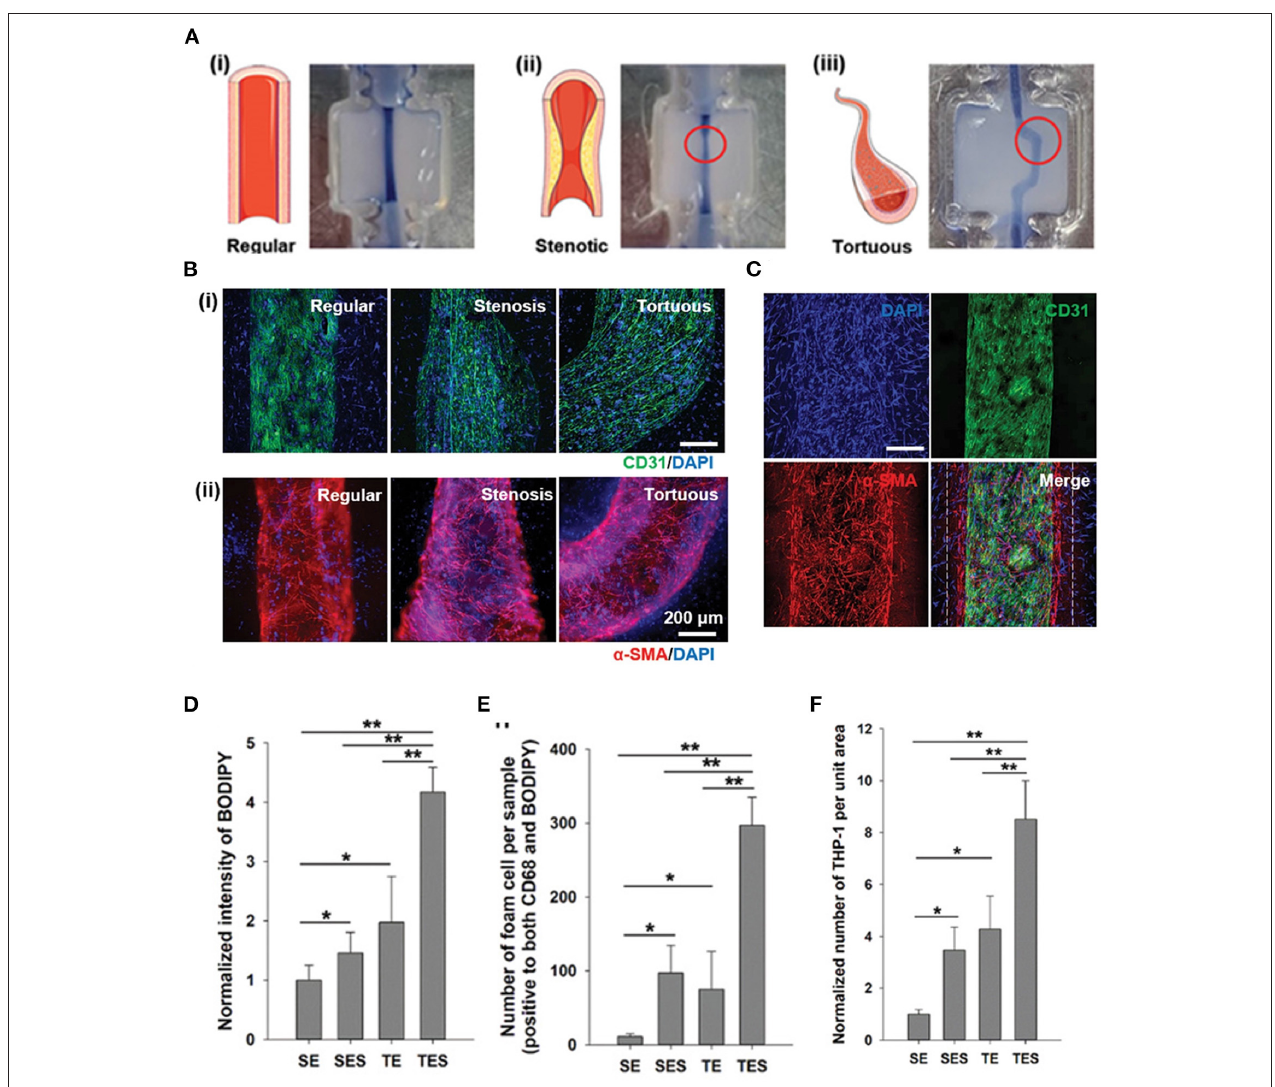
FIGURE 4 | Construction of a novel in vitro atherosclerotic model from geometry-tunable artery equivalents engineered via in-bath coaxial cell printing. (A) By programming the printing path and moving speed, triple-layer arterial constructs with controlled geometries were achieved, including (i) regular straight, (ii) stenotic, and (iii) tortuous models. (B) (i) Confluent endothelium and (ii) dense smooth muscle tissues were generated in the constructed artery equivalents on day 7, regardless of the designed geometries (Scale: 200 µ m). (C) The distributions of a monolayer endothelium surrounded by compartmentalized smooth muscle cells and fibroblasts (white dashes) are distinguishable (D) Quantification of LDL accumulation, (E) foam cells, and (F) adhered THP-1 cells. SE: steady-flow model containing only ECs; SEC: steady-flow model containing ECs and SMCs/fibroblasts; TE: turbulent-flow model containing only ECs; TES: turbulent-flow model containing EC and SMS/fibroblasts. Adapted, with permission from (171). * P < 0.05; ** P <